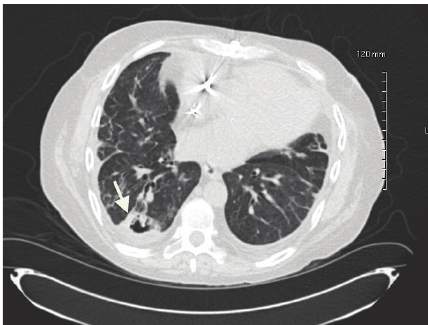
Figure 4: Axial chest computed tomography scan after two weeks of antifungal therapy showing thick-walled, subpleural cavitation and nodules